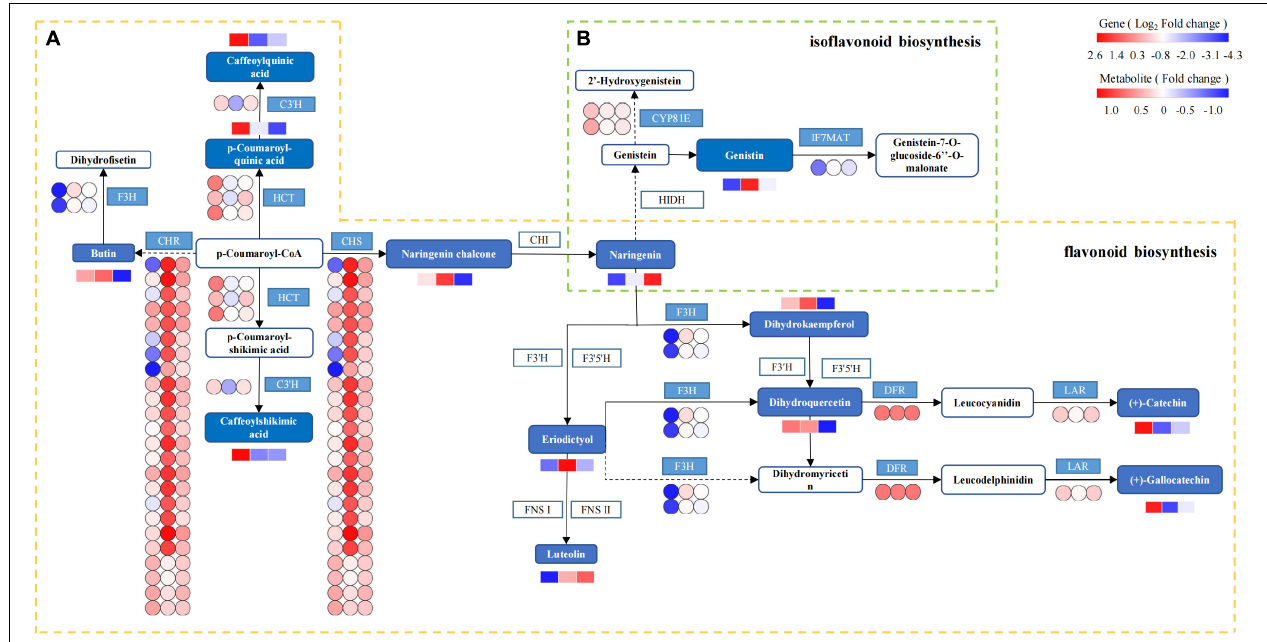
FIGURE 11 | The DEGs and DEMs involved in flavonoid and isoflavonoid biosynthesis in response to cold stress. The flavonoid biosynthesis process is given within the yellow dotted box (A) , and the isoflavonoid biosynthesis is within the green dotted box (B) . The blue pattern represents the annotated metabolites or genes. The rectangle is divided into three equal parts (the left of the rectangle represents DEGs or DEMs in CK, the middle of the rectangle represents DEGs or DEMs in TH-0%, and the right of the rectangle represents DEGs or DEMs in TH-75%). The color in the rectangle represents that the genes or metabolites are regulated under cold stress (red indicates upregulation and blue indicates downregulation). CHS: chalcone synthase; CHR: chalcone reductase; HCT: shikimate O -hydroxycinnamoyl transferase; C3 (cid:48) H: 5- O -(4-coumaroyl)- D -quinate 3 (cid:48) -monooxygenase; LAR: leucoanthocyanidin reductase; F3H: naringenin 3-dioxygenase; DFR: bifunctional dihydroflavonol 4-reductase; IF7MAT: isoflavone 7 -O- glucoside-6 (cid:48)(cid:48) -O- malonyltransferase; and CYP81E: